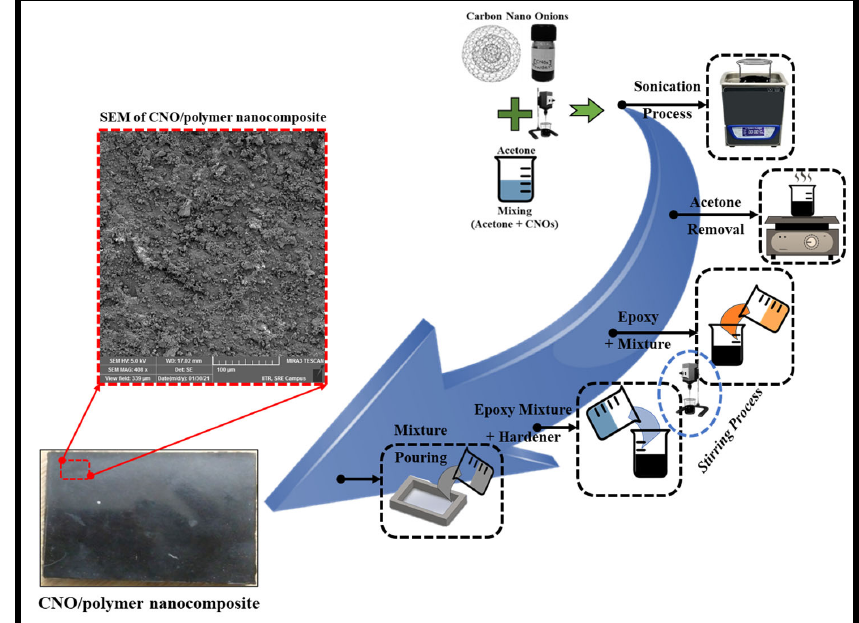
Fig. 1. Fabricated specimen of CNO/polymer nanocomposite for Milling tests